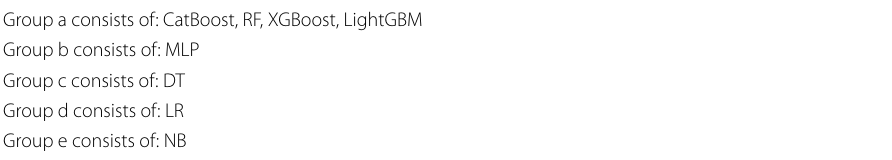
Table 43 HSD test groupings after ANOVA of AUPRC for the classifier factor